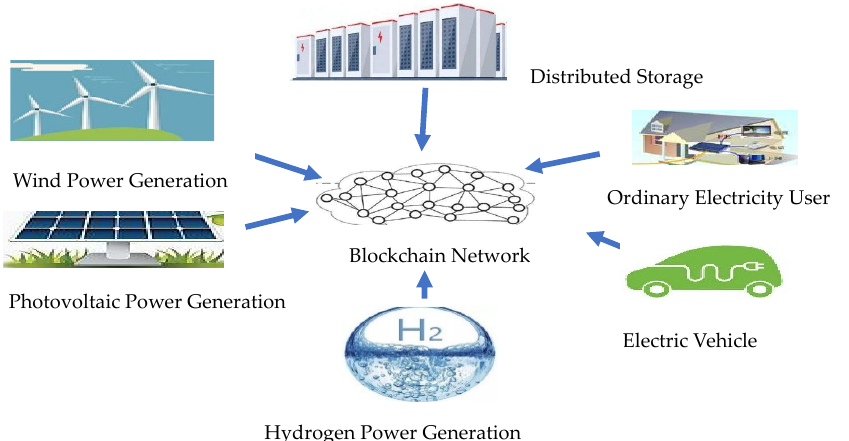
Figure 3. Schematic showing the application of the blockchain technology in microgrid.